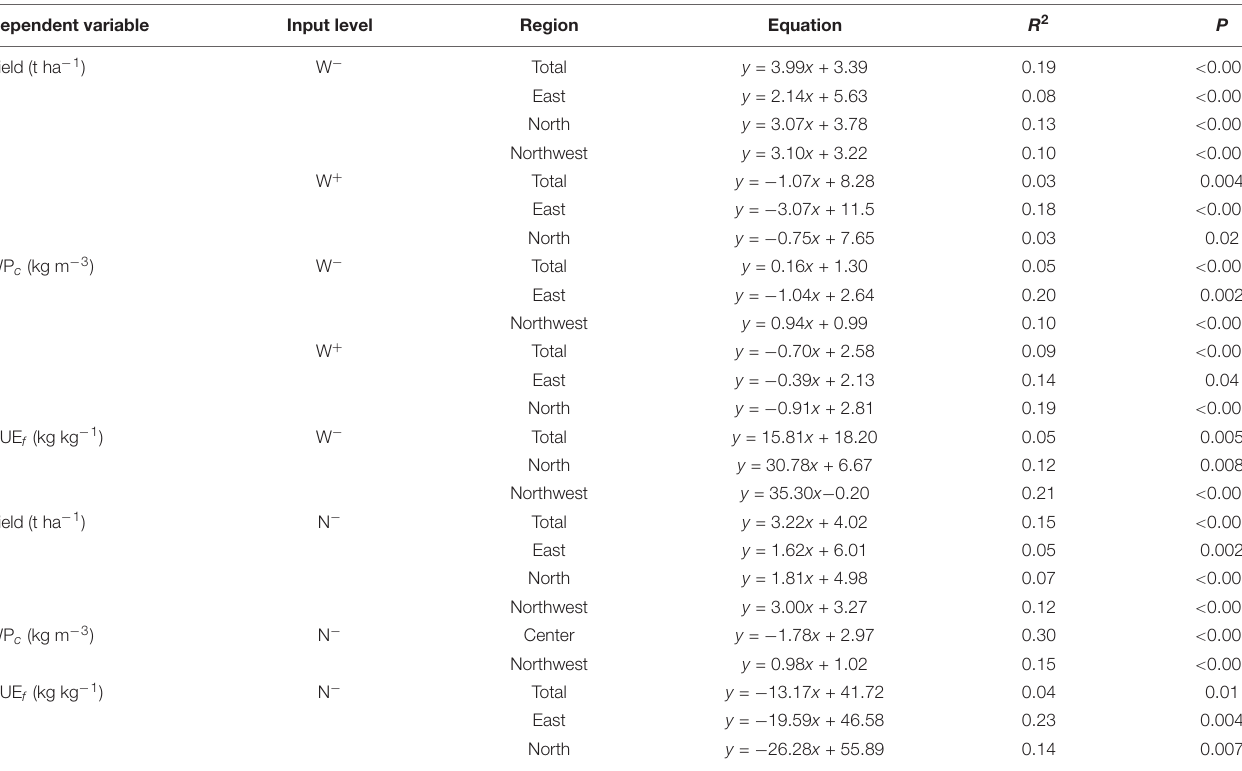
TABLE 2 | Linear regression model of the effects of the input level of water and nitrogen (N) on yield, water productivity (WP c ), and N use efficiency (NUE f ). Dependent